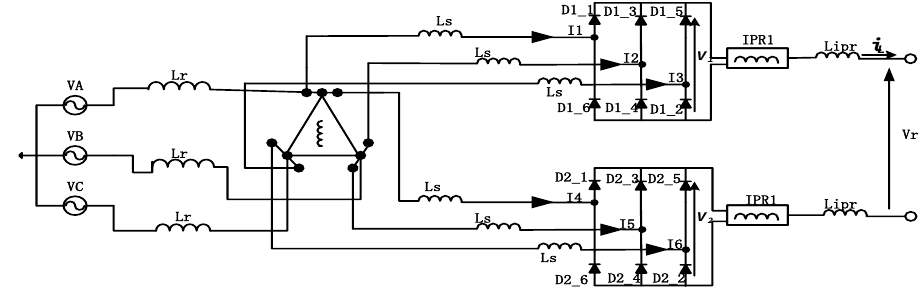
Figure 2. Schematic of autotransformer based 12-pulse rectifier.